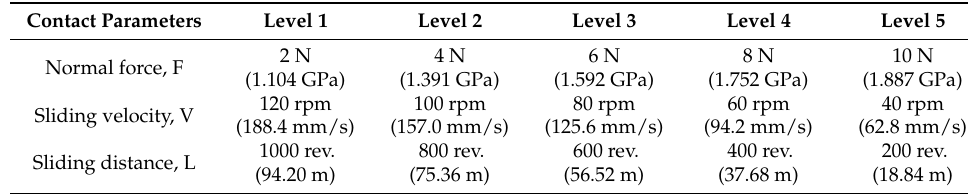
Table 3. Contact parameters and factor levels for a pin-on-disk test.